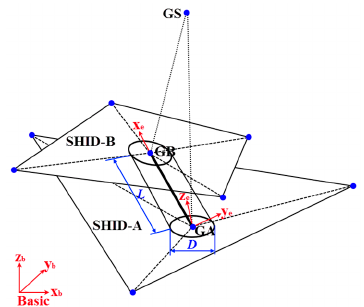
Figure 8. Connection between two surface patches.